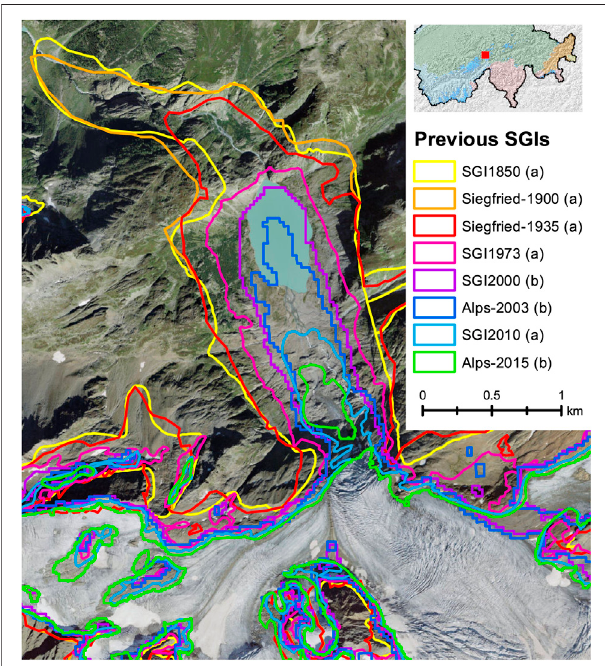
FIGURE 2 | Compilation of glacier outlines from previous inventories available in digital format of Swiss glaciers for the example of Triftgletscher, Central Switzerland. Glacier outlines are in general either based on (a) maps, aerial images and manual digitizing, or (b) satellite images and semi- automated mapping. In the background, a SWISSIMAGE orthophoto acquired in 2018 is shown. The location within Switzerland is indicated in the inset (red